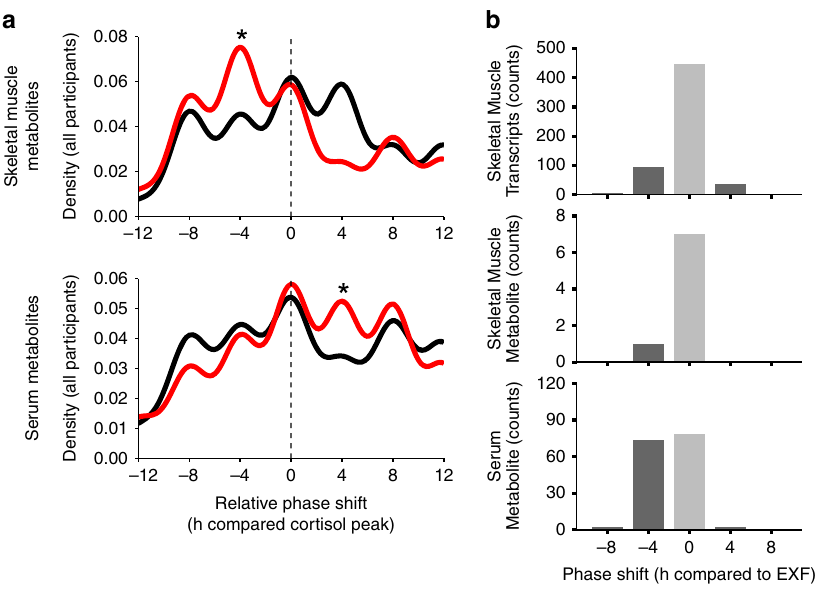
Fig. 4 Circadian alignment of periodic features. Density plot showing the relative phase shift compared to the cortisol maximum for all individuals combined for skeletal muscle (top panel) and serum metabolites (bottom panel) with the black line showing extended feeding (EXF), and the red line showing time-restricted feeding (TRF) ( a ). Histogram of TRF phase shift relative to EXF at the feature level for skeletal muscle transcripts (top panel, p < 2.2 * 10 − 16 ), skeletal muscle metabolites (middle panel) and serum metabolites (bottom panel. p ≈ 7.74 * 10 − 12 ) ( b ). * p < 0.05 Kolmogorov – Smirnov two sample and two sided test for EXF versus TRF, n = 11